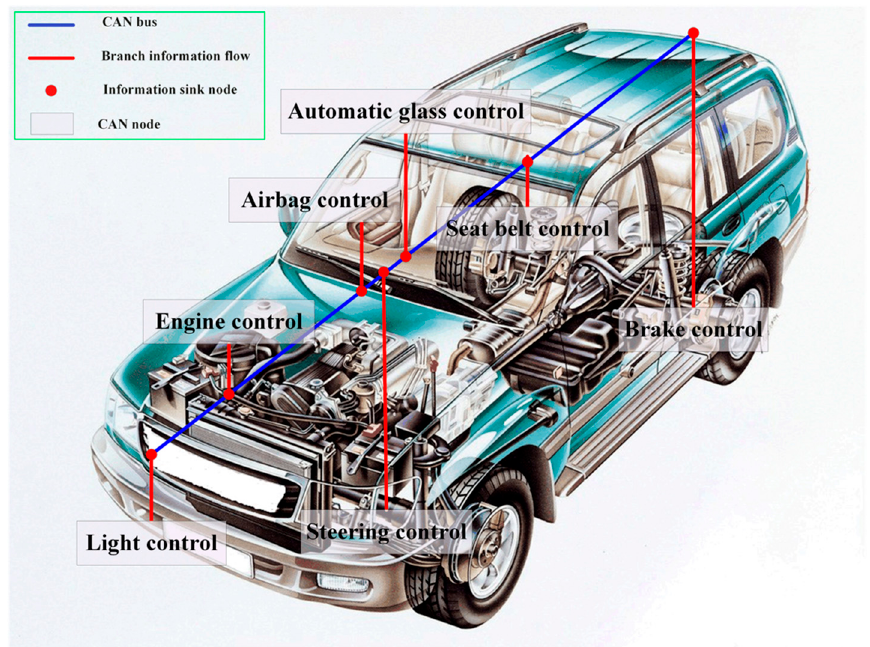
Figure 1. Controller area network (CAN) bus in an intelligent vehicle. Date information from control electronic units is collected on the CAN bus through CAN nodes.